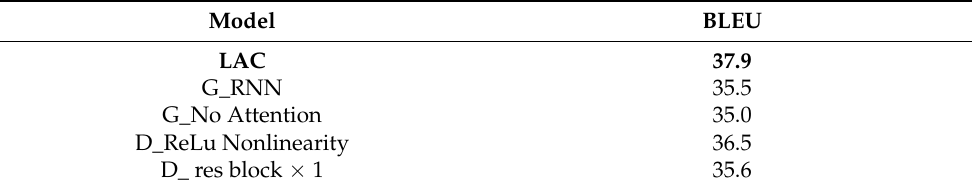
Table 9. Ablation Study of LAC in Turkish-English Sentence Pairs.